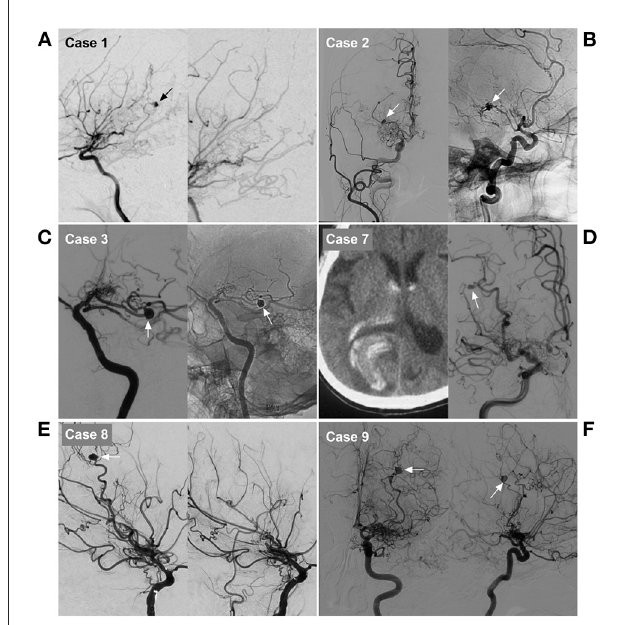
FIGURE4 Imaging characteristics of cases 1, 2, 3, 7, 8 and 9 in Table 1. (A) Case 1: Left, DSA of the ICA showed an aneurysm on the distal AchA (arrow). Right: Postoperative DSA showing that both the parent artery and aneurysm were occluded with Onyx. (B) Case 2: Left, DSA of the carotid artery showed an aneurysm on the distal AchA (arrow). Right: Postoperative DSA showing that both the parent artery and aneurysm were occluded with coiling (arrow). (C) Case 3: Left, DSA of the ICA showed an aneurysm on the distal AchA (arrow). Right: Postoperative DSA showing that both the parent artery and aneurysm were occluded with coiling (arrow). (D) Case 7: Left, CT showed hemorrhage of the right occipital lobe into the lateral ventricle. Right: DSA of the ICA showing the aneurysm (arrow) located on the P4–5 segment of the PCA. (E) Case 8: Left, DSA of the ICA showed an aneurysm on the distal LSA (arrow). Right: Postoperative DSA showing that both the parent artery and aneurysm were occluded. (F) Case 9: DSA of the ICA in the anterior-posterior view (left) and lateral view (right) showed an aneurysm on the distal LSA (arrow). AchA, anterior choroidal artery; CT, computed tomography; DSA, digital subtracted angiography; ICA, internal carotid artery; LSA, lenticulostriate artery; PAO, parent artery occlusion; PCA, posterior cerebral